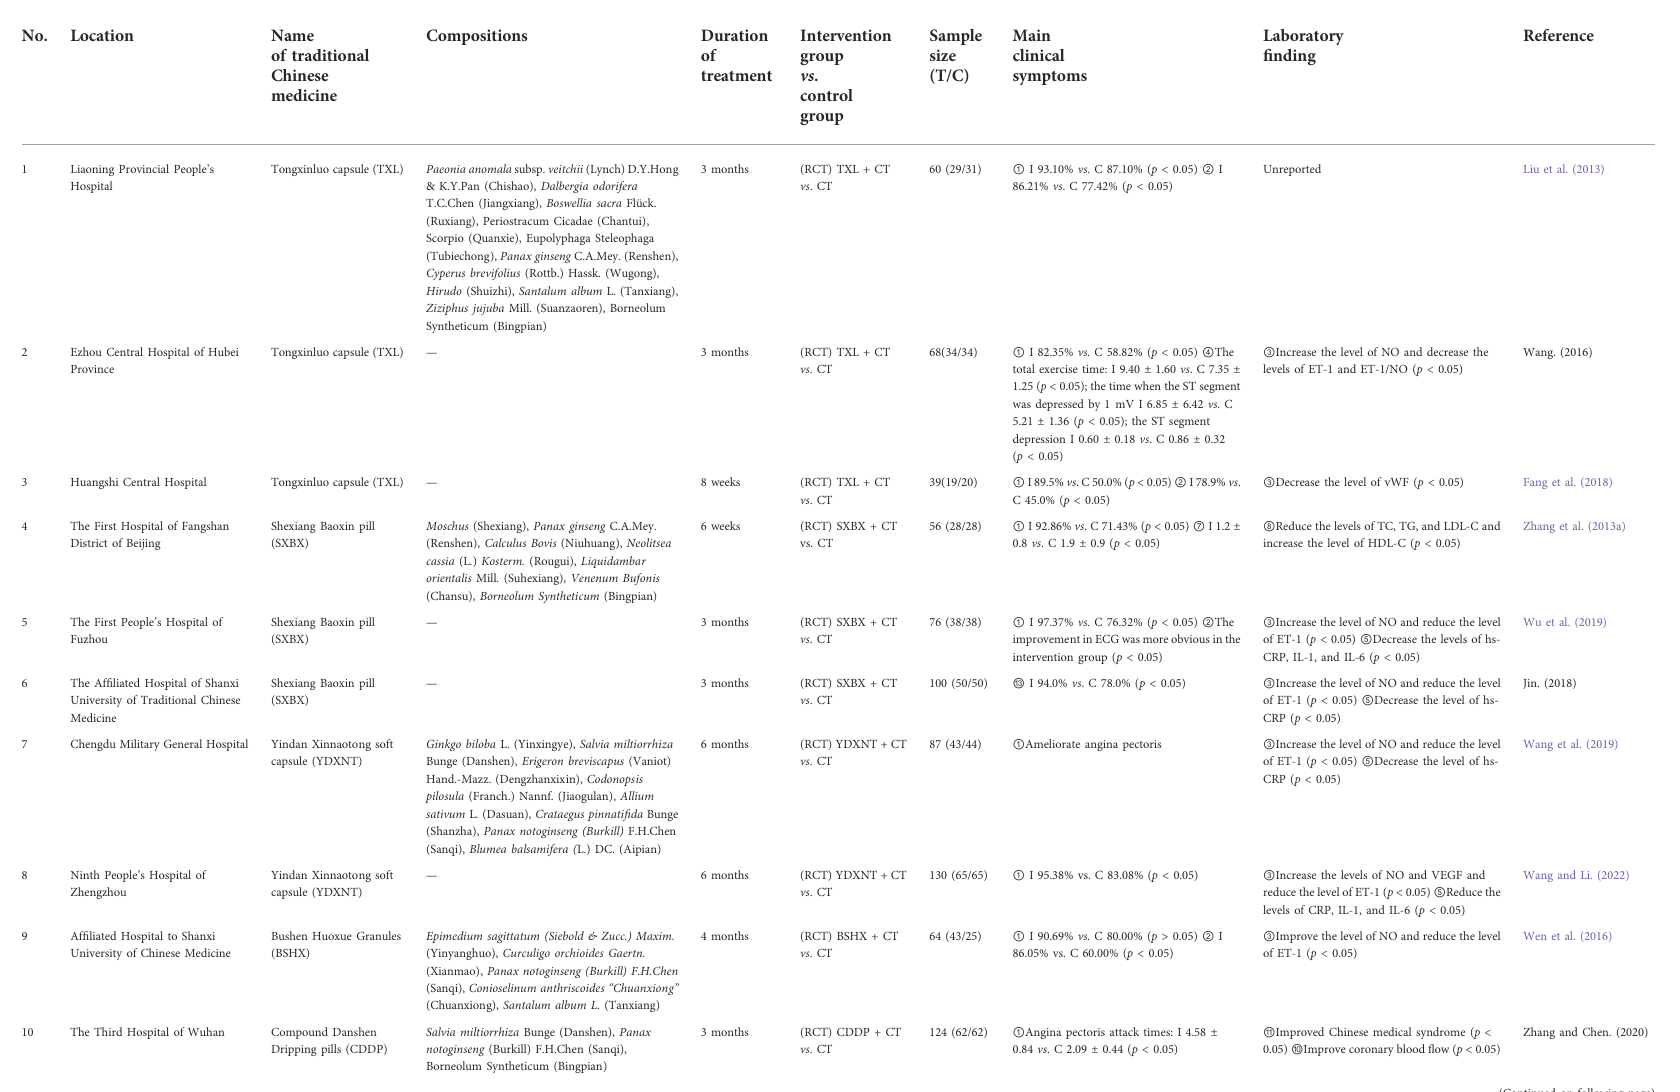
TABLE 1 Clinical evidence of TCM for